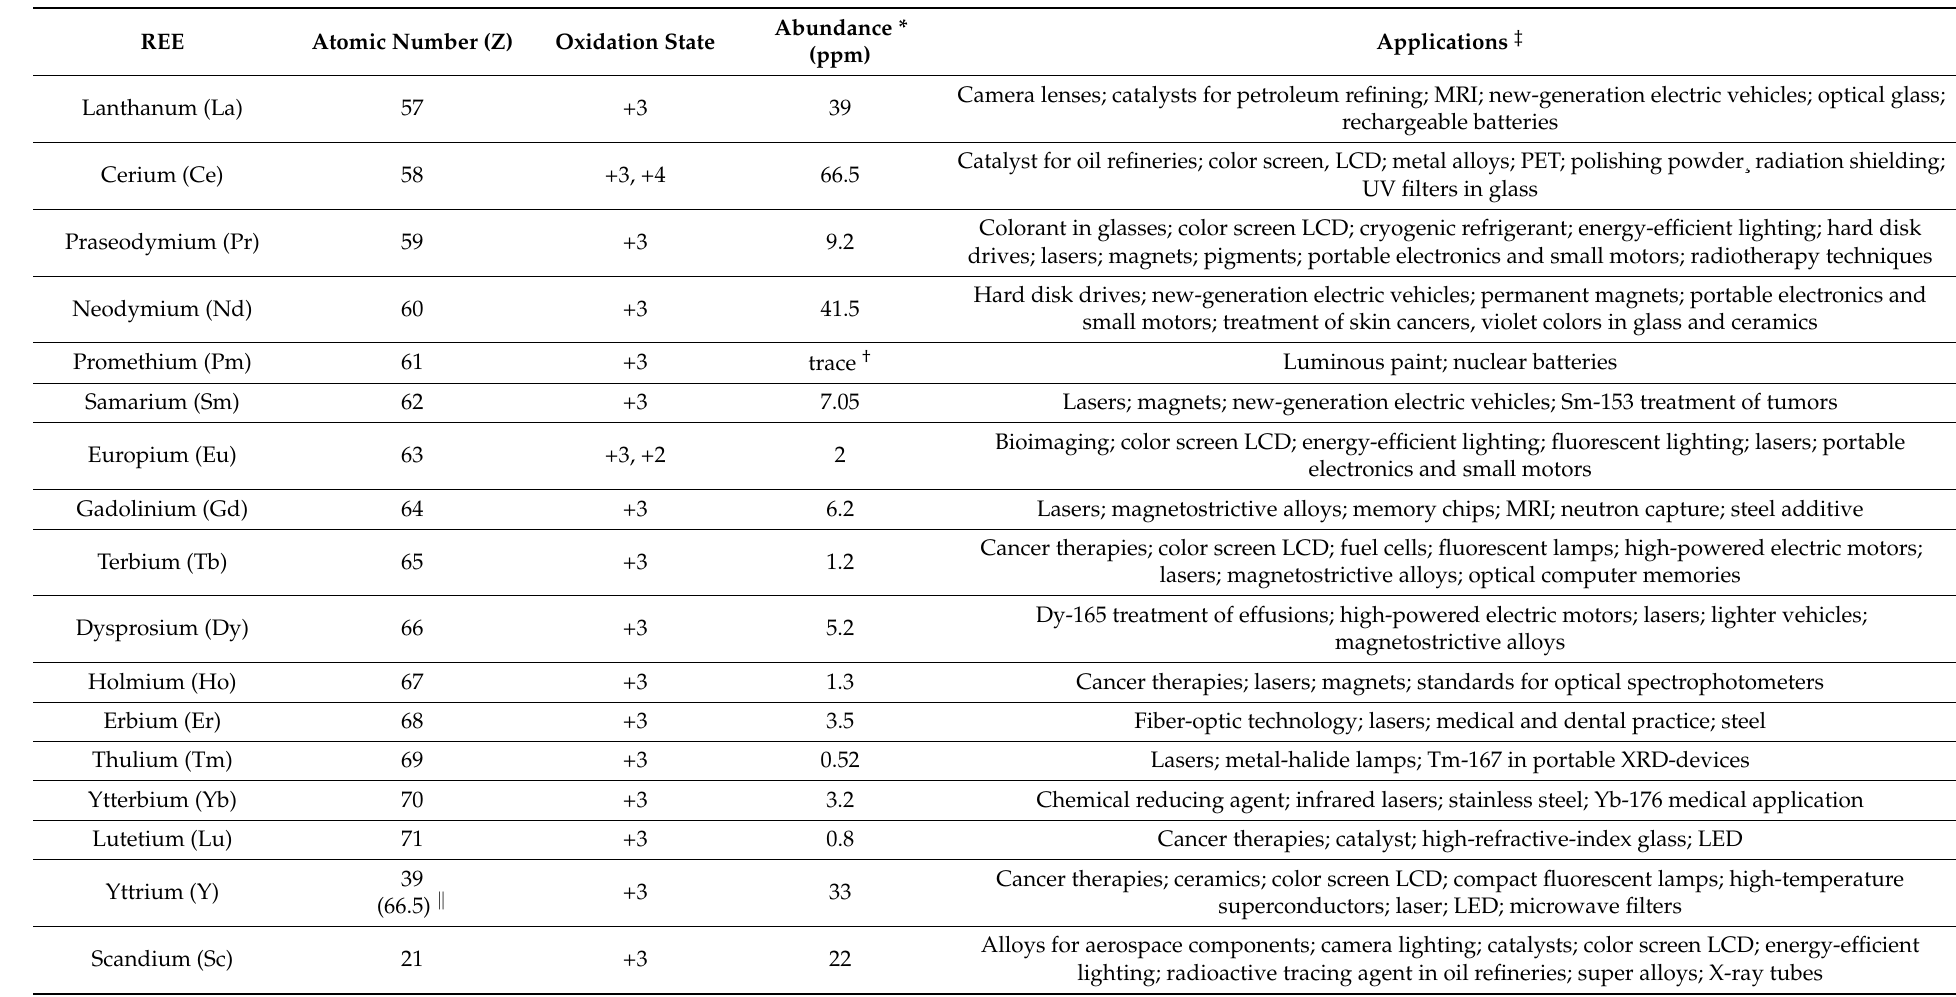
Table 1. List of the rare earth elements (REE), their relative abundances in the earth’s crust (ppm), and main